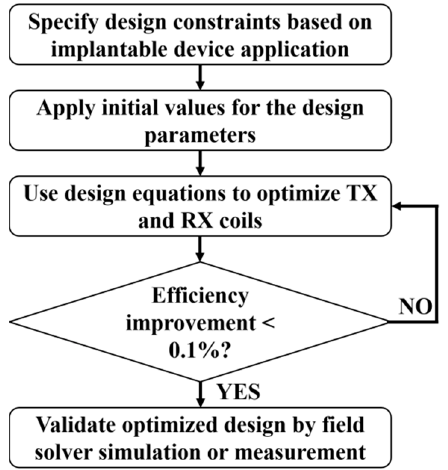
Figure 5. Optimization flow graph of NRIC WPT system.